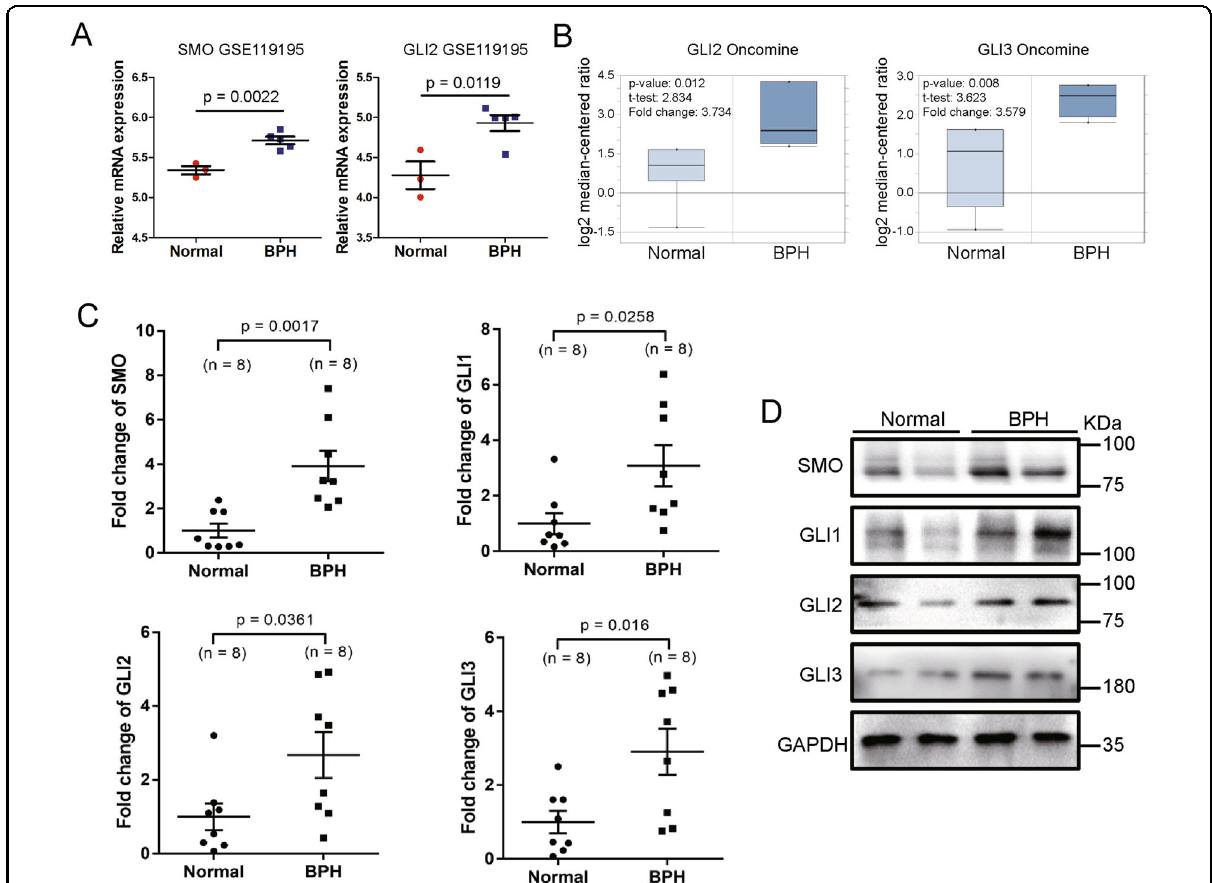
Fig. 1 SMO and GLI1 – 3 are strongly upregulated in BPH tissues compared with the normal ones. A The mRNA expression of SMO and GLI2 in BPH and NP through GSE119195 dataset. B The mRNA expression of GLI2 and GLI3 in BPH and NP through Tomlins Prostate from Oncomine database. C , D The relative mRNA and protein expression of SMO, GLI1, GLI2, and GLI3 in BPH tissues versus normal prostate tissues. Two-tailed Student ’ s t